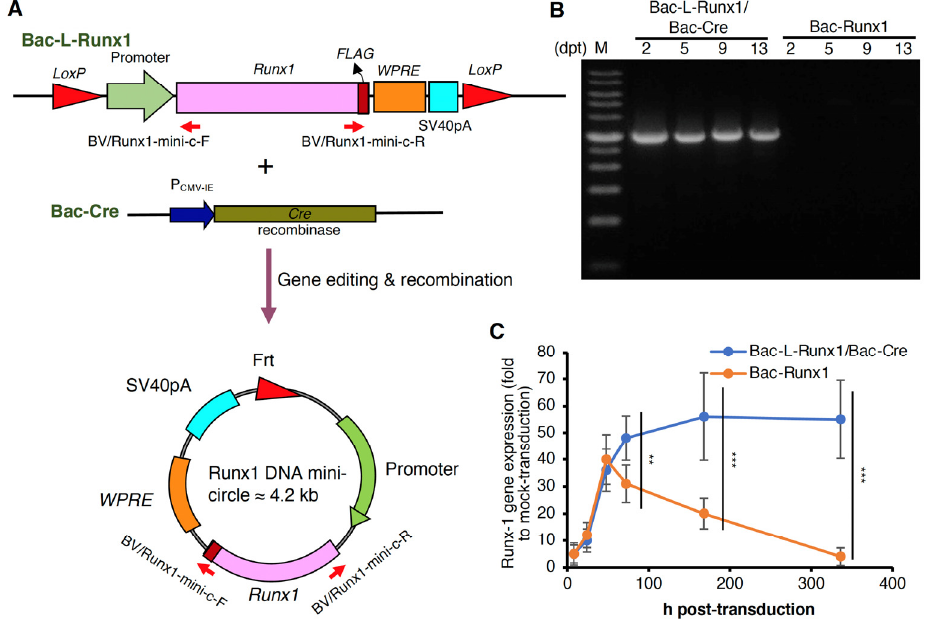
Figure 1. Cre/LoxP BV mediated genetic recombination, and DNA mini-circle formation efficiently sustained the transgene expression. ( A ) Illustration of Cre/LoxP BV medicated gene editing and DNA mini-circle formation. Red arrows indicate the primer pairs used to detect the DNA mini-circle formation. ( B ) The DNA mini-circle formation at 2- to 13-dpt was examined by PCR. Gene fragment was amplified through PCR reaction using BV/Runx1-mini-C-F and BV/Runx1-mini-C-R primer pairs. PCR amplicon ≈ 3085 bp. ( C ) The runx1 gene expression of recombinant BV transduction from 8 to 336 h post-transduction was examined by qRT-PCR. ( n = 3) ** p < 0.01; *** p < 0.001.